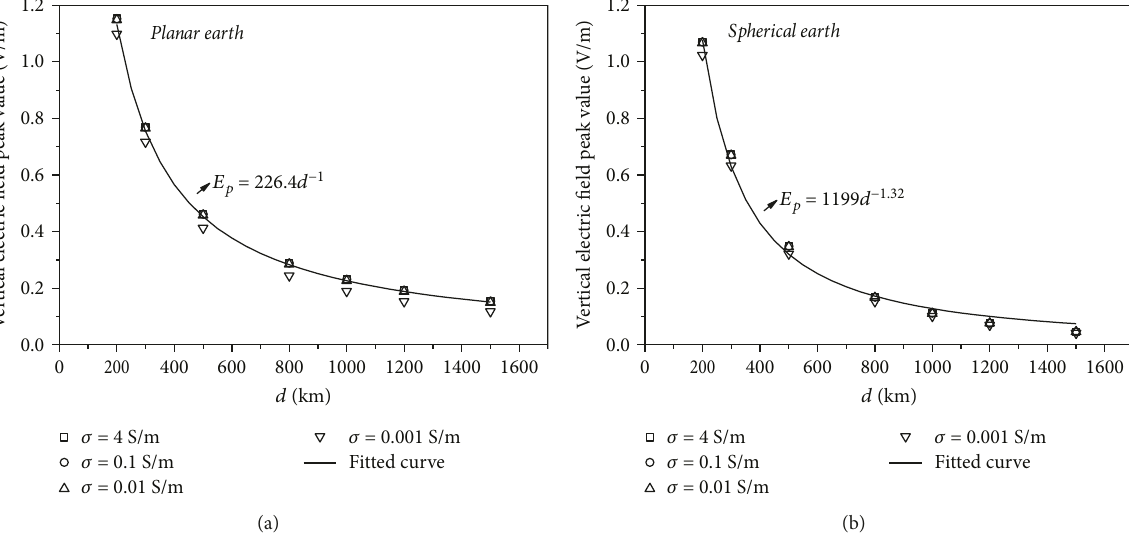
Figure 7: The lightning-radiated vertical electric fi eld peak value as a function of propagation distance for (a) the planar earth and (b) the spherical earth. The lightning current source shown in Figure 2 is adopted. The solid curves are the fi tted results of average fi eld peak value for earth conductivity ranges from 0.001S/m to 4